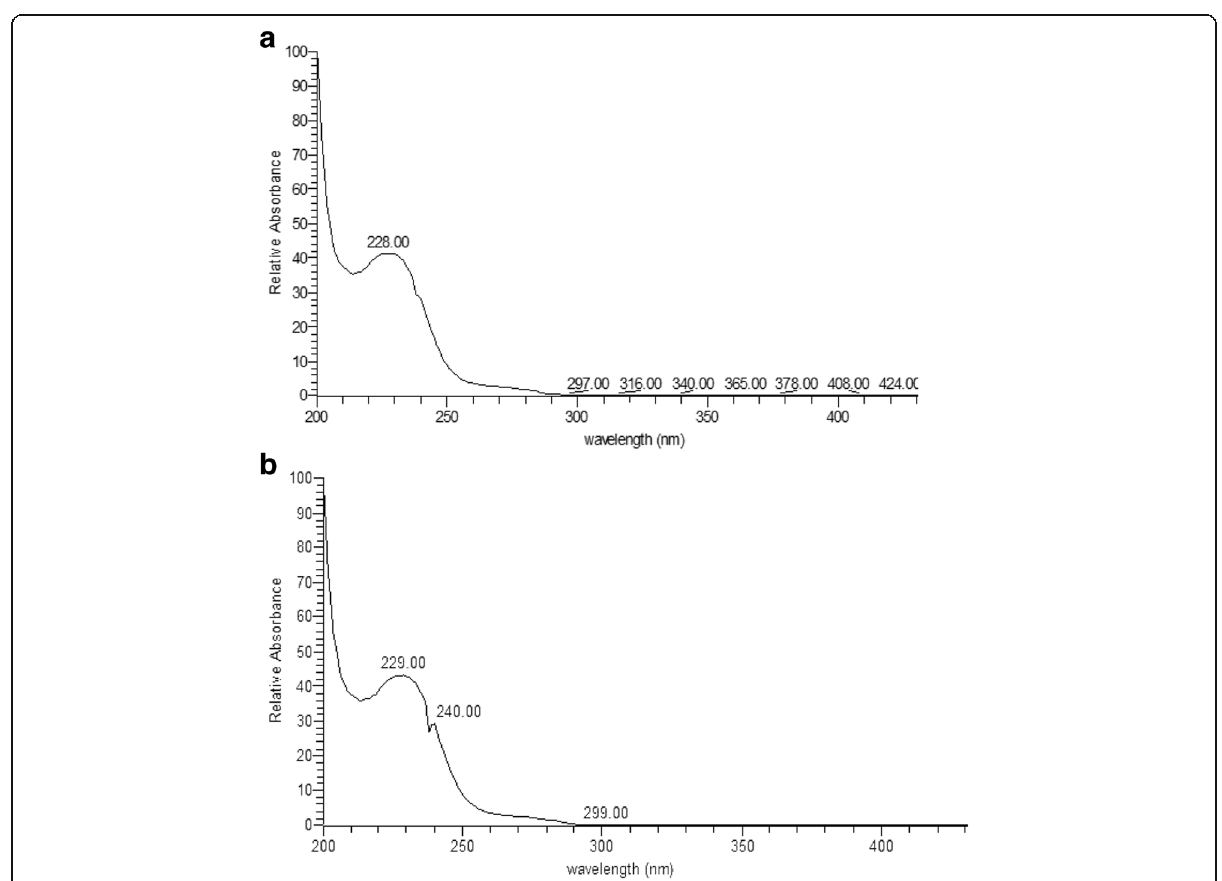
Fig. 3 UV-visible spectroscopic analysis. a Fungal EDT ( b )